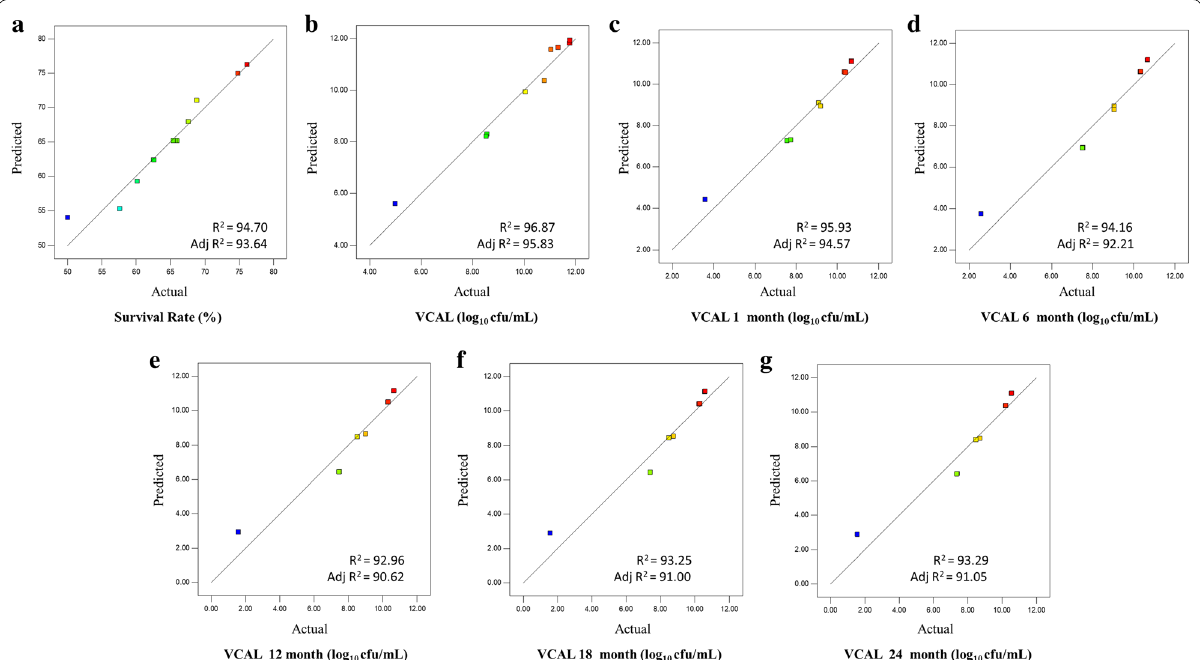
Fig. 1 Predicted vs. actual plot of: a survival rate (%), log 10 CFU/mL values obtained in b viable count after lyophilization [VCAL], c VCAL 1 month, d VCAL 6 months, e VCAL 12 months, f VCAL 18 months and g VCAL 24 months lyophilized probiotics